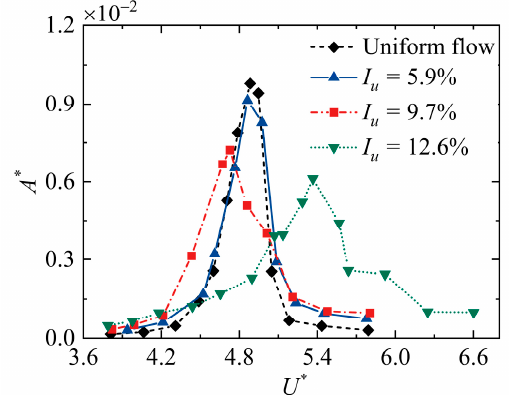
Figure 9. The variation in A* versus U* for different I u .